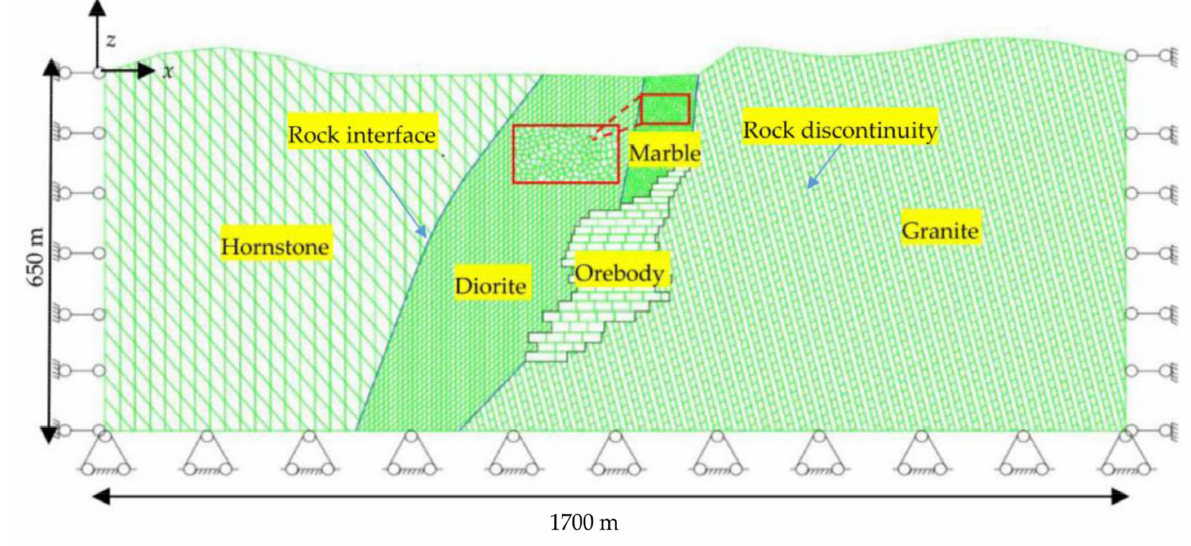
Figure 6. UDEC numerical model corresponding to the geological profile along line no. 4 (green lines denote discontinuities; blue lines denote the interfaces between different rock masses; red rectangles denote the partial enlarged detail of Voronoi